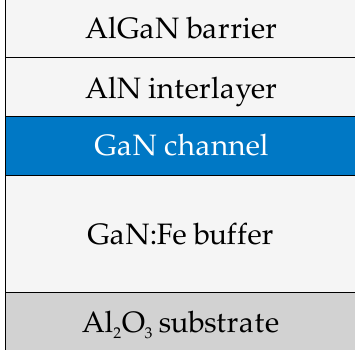
Figure 1. Epitaxial layer schematic.